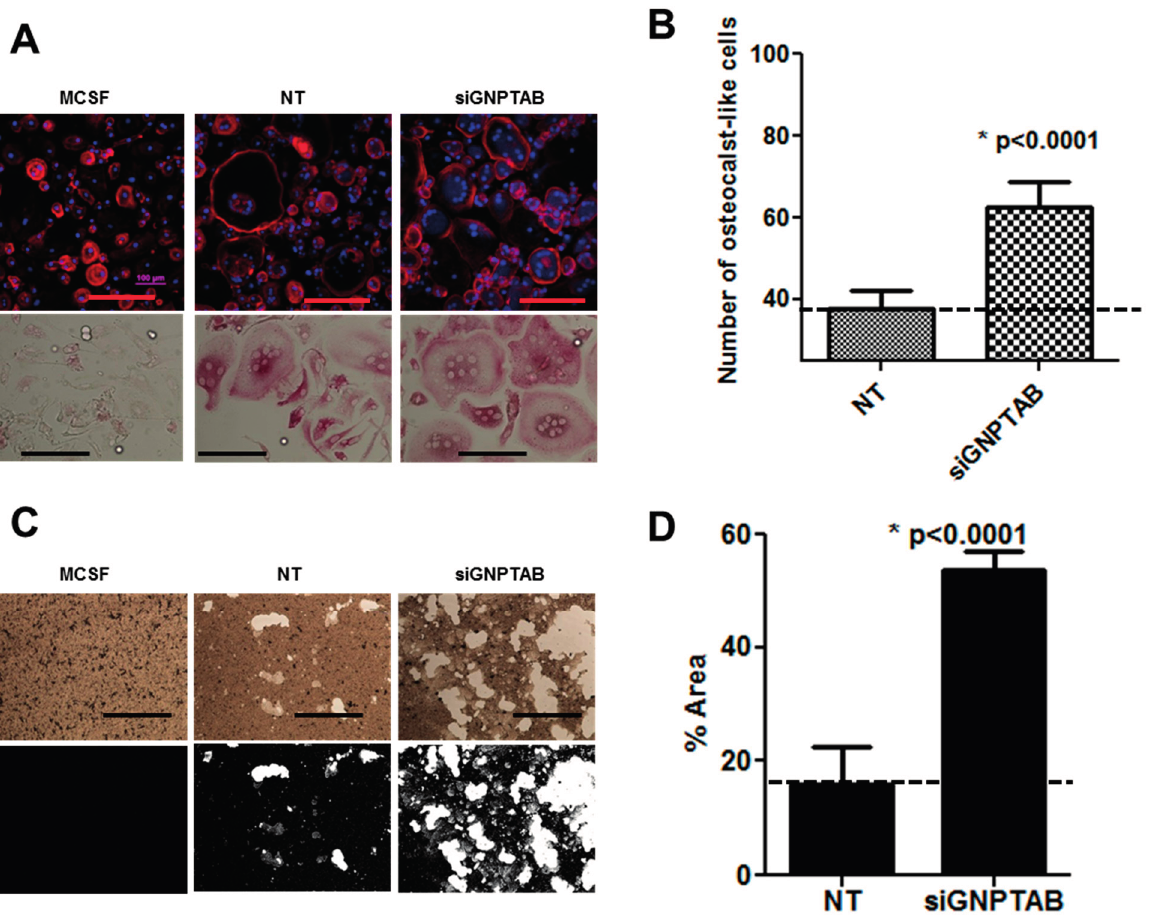
Figure 4. ( A ) Cellular morphology by F-actin immunofluorescence (top row) and TRAP staining (bottom row). F-actin rings were stained by Alexa Fluor ® 594 phalloidin (Red) and Nuclei were stained by DAPI (Blue). TRAP activity assay showed increased numbers of multinucleated osteoclast-like cells. Top row: bars = 200 µm. Bottom row: bars = 200 µm. ( n = 4, two or five technical replicates each); ( B ) Number of osteoclast-like cells counted based on TRAP staining ( n = 4, two or five technical replicates each); ( C ) Pit resorption assays showed resorption pits (white color) formed by functional osteoclasts ( n = 4, one or two technical replicates each). Black and white binary images converted by Image